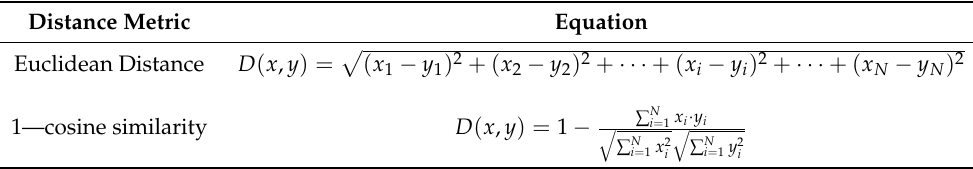
Table 3. Distance metrics that are used in triplet